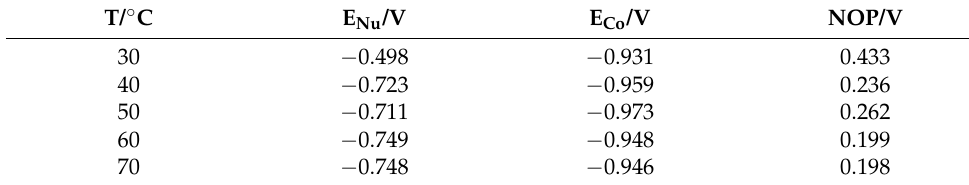
Figure 3. Cyclic voltammograms of Co-Mo electrodeposition in electrolytes with different temperatures. Table 3. The kinetic parameters for Co-Mo electrodeposition in different temperatures.